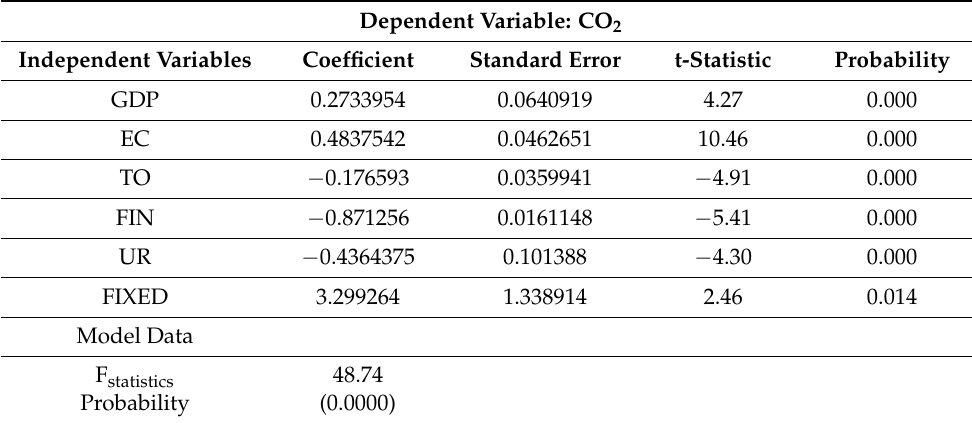
Table 7. One-way (fixed) effects model